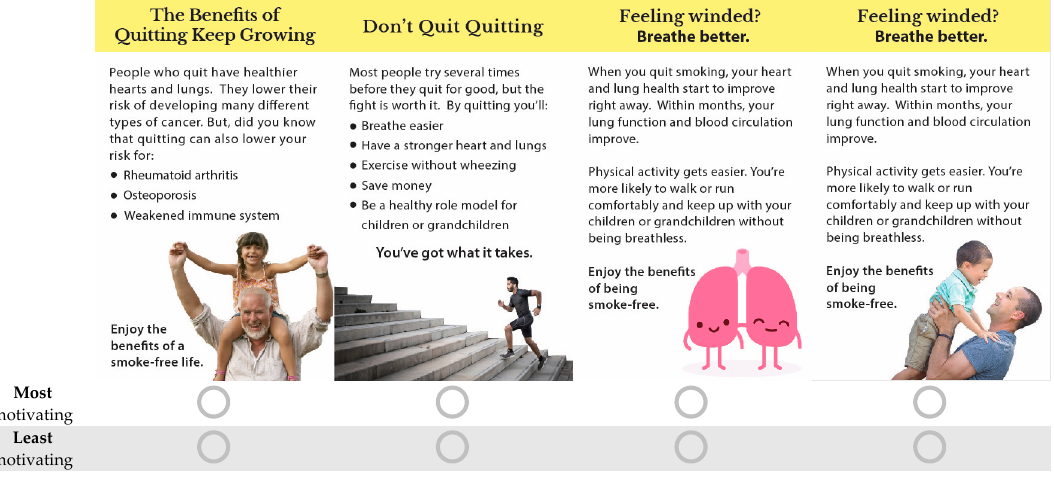
Figure 4. Example choice set for DCE 1.